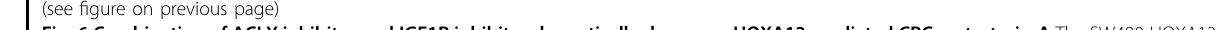
Fig. 6 Combination of ACLY inhibitor and IGF1R inhibitor dramatically decreases HOXA13-mediated CRC metastasis. A The SW480-HOXA13 cells were respectively treated with ACLY inhibitor ETC-1002 (100 μ M, 12 h), IGF1R inhibitor Linsitinib (10 μ M, 6 h) or both two agents. The protein expression levels of p-AMPK α , total AMPK α , p-IGF1R, and total IGF1R were detected by western blotting. B Transwell assays showed the migratory and invasive capabilities of SW480-HOXA13 cells after treatment with ACLY inhibitor ETC-1002 (100 μ M, 12 h), IGF1R inhibitor Linsitinib (10 μ M, 6 h) or the combination of both two agents. C The diagram of agent treatment in four randomly assigned groups of nude mice. These mice were treated with vehicle, ETC-1002 (30 mg/kg), Linsitinib (50 mg/kg) or combined treatment 1 week after injection of SW480-HOXA13 cells. D In vivo liver metastatic assays revealed that combined administration of ETC-1002 and Linsitinib signi fi cantly suppress HOXA13-mediated CRC metastasis. Four stable cell lines were injected into the spleens of nude mice ( n = 10 mice per group). Representative bioluminescent imaging, intensity of bioluminescence signals, incidence of liver metastasis, liver tissues ’ HE staining, number of metastatic liver nodules, and overall survival times in each group were shown. The scale bars represent 1 mm (low magni fi cation) and 100 μ m (high magni fi cation). E In vivo lung metastatic assays revealed that combined administration of ETC-1002 and Linsitinib signi fi cantly suppress HOXA13-mediated CRC metastasis. Four stable cell lines were injected into the tail veins of nude mice ( n = 10 mice per group). Representative bioluminescent imaging, intensity of bioluminescence signals, number of metastatic lung nodules, overall survival times, lung tissues ’ HE staining in each group, and the incidence of lung metastasis were shown. The scale bars represent 1 mm (low magni fi cation) and 100 μ m (high magni fi cation). F A schematic diagram for the role of IGF1-HOXA13-IGF1R positive feedback loop in CRC metastasis. IGF1-IGF1R pathway upregulates HOXA13 via PI3K/AKT/HIF1 α pathway. HOXA13 promotes CRC metastasis through upregulating ACLY and IGF1R expression. Combined administration of ACLY inhibitor (ETC-1002) and IGF1R inhibitor (Linsitinib) disrupts the IGF1- HOXA13-IGF1R loop and inhibits CRC metastasis. * P < 0.05, ** P < 0.01. Data are displayed as the mean ±